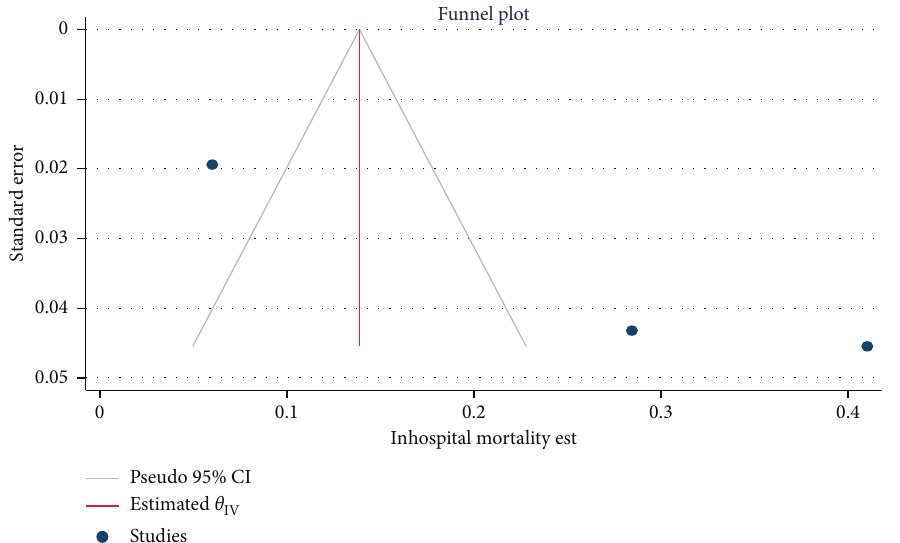
Figure 5: Funnel plot for assessing publication bias across mortality estimates among chronic liver disease patients in Ethiopia,